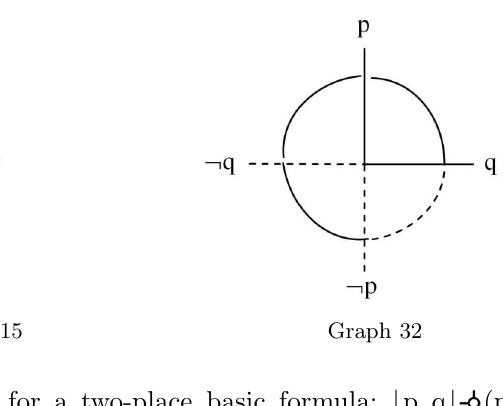
Schema 15 stands for a two-place basic formula: ⌊ p q ⌋ (pq), while graph 32 (also see graph 10(b), 11(c)) stands for assertions: ⊢ p ∨¬